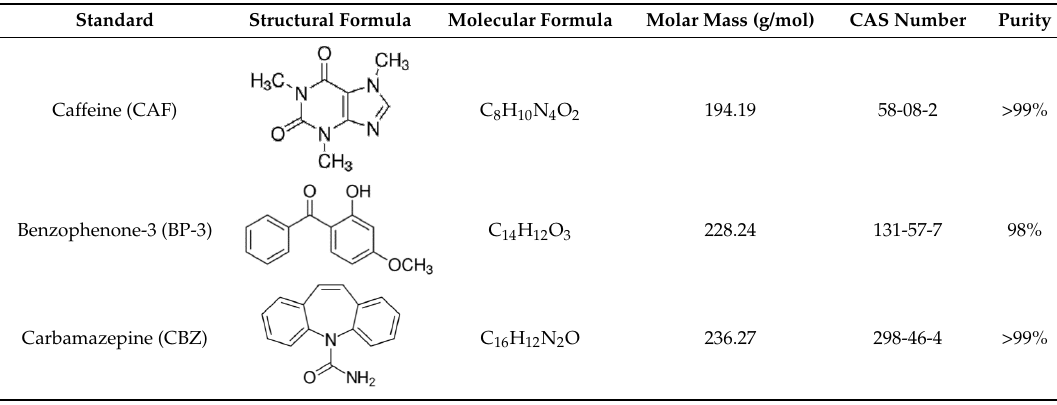
Table 1. Characteristics of tested compounds.